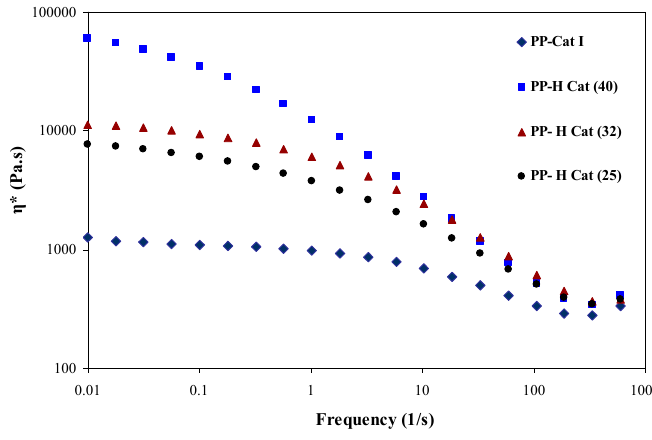
Figure 5. Complex viscosity versus frequency for the synthesized PP reactor blends.